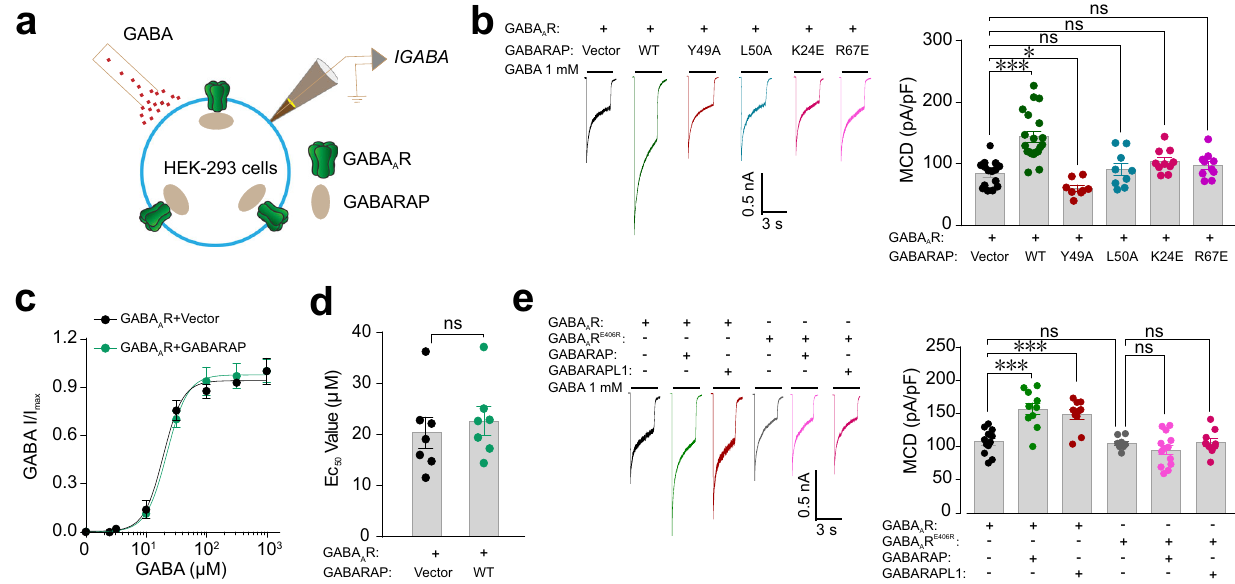
Fig. 4 Effects of GABARAP on GABA A R-mediated current densities in HEK-293 cells co-expressing diverse GABARAP and GABA A Rs variants. a Schematic diagram for patch-clamp recordings of HEK-293 cells. b Representative trace records and average values of GABA currents ( I GABA ) activated by 1 mM GABA in HEK-293 cells co-expressing GABA A Rs ( α 1 β 2 γ 2) and WT or mutant GABARAP. n = 15, 20, 8, 9, 10, and 10 of each group (from left to right). Data are represented as the mean ± SEM. *** P = 0.0001, GABA A R vs. GABA A R + GABARAP; * P = 0.0108, GABA A R vs. GABA A R + GABARAP Y49A based on one-way ANOVA; ns not signi fi cant ( P > 0.05). c Dose – response curves of I GABA in HEK-293 cells co-expressing GABA A Rs ( α 1 β 2 γ 2) and GABARAP. The data were normalized to I max of the each group. GABA at 1, 3, 10, 30, 100, 300, and 1000 μ M were selected. Data were fi t using the Hill equation with variable slope. Data are represented as the mean ± SEM. n = 7. d EC 50 values of I GABA induced by increasing GABA concentrations in HEK-293 cells co-expressing GABA A R ( α 1 β 2 γ 2) and GABARAP. n = 7. Data are represented as the mean ± SEM. ns not signi fi cant ( P > 0.05) based on unpaired t test. e Representative trace records and average values of GABA currents activated by 1 mM GABA in HEK-293 cells co-expressing GABA A R ( α 1 β 2 γ 2 E406R ) and GABARAP or GABARAPL1. n = 12, 10, 13, 8, 10, and 10 of each group (from left to right). Data are represented as the mean ± SEM. *** P = 0.0001, GABA A R vs. GABA A R + GABARAP; *** P = 0.0010, GABA A R vs. GABA A R + GABARAPL1 based on one-way ANOVA; ns, not signi fi cant ( P >